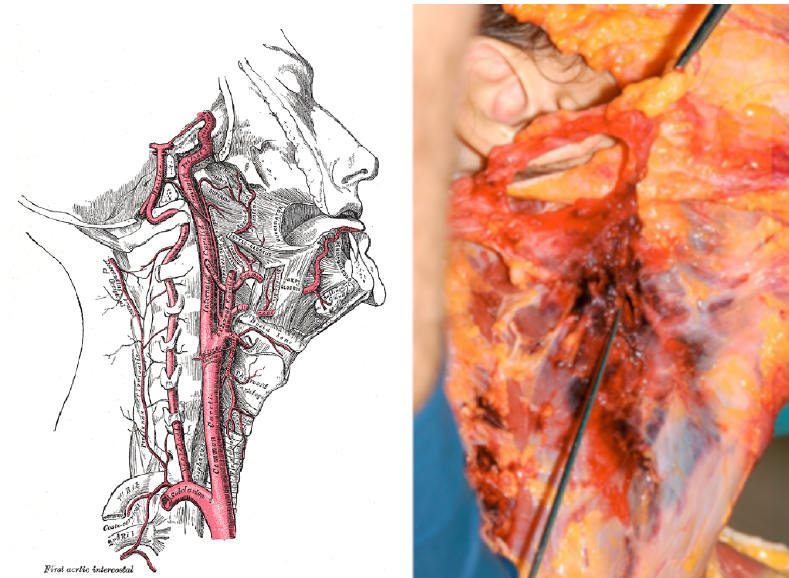
Figure 1. Anatomic representation of external carotid artery ( left panel , figure from https://it. wikipedia.org/wiki/Arteria_carotide_esterna, accessed on 10 January 2023); external carotid artery injury ( right panel ) in the